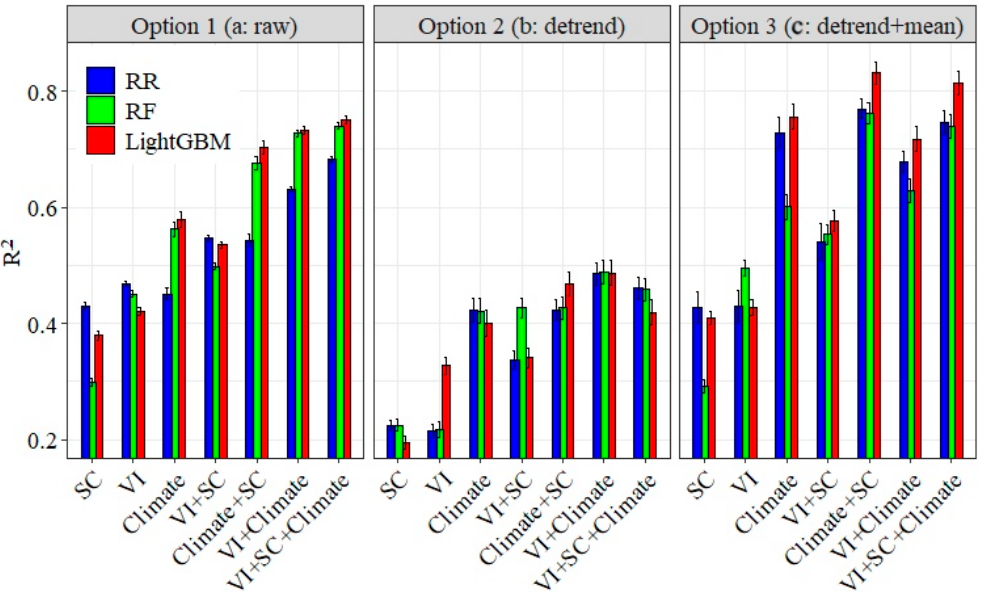
Figure 4. The model performances (predicted R2) of the three methods separated by the three Options with di ff erent inputs for the entire growing season. ( a ) “Raw”; ( b ) “Detrend”; and ( c ) “Detrend + Mean”. The blue color is for RR, green for RF and red for LightGBM. The error bars are one standard deviation of predicted R 2 from 100 ensembles by randomly dividing training and testing datasets.